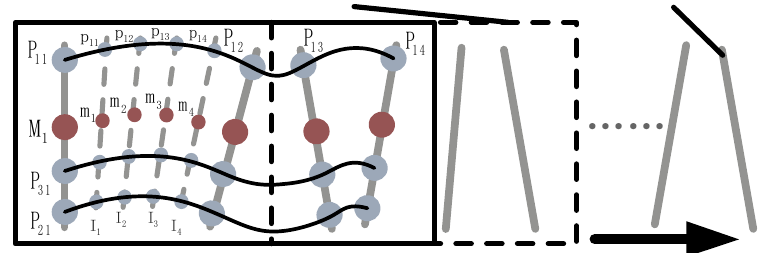
Figure 3. Bezier interpolation control window.